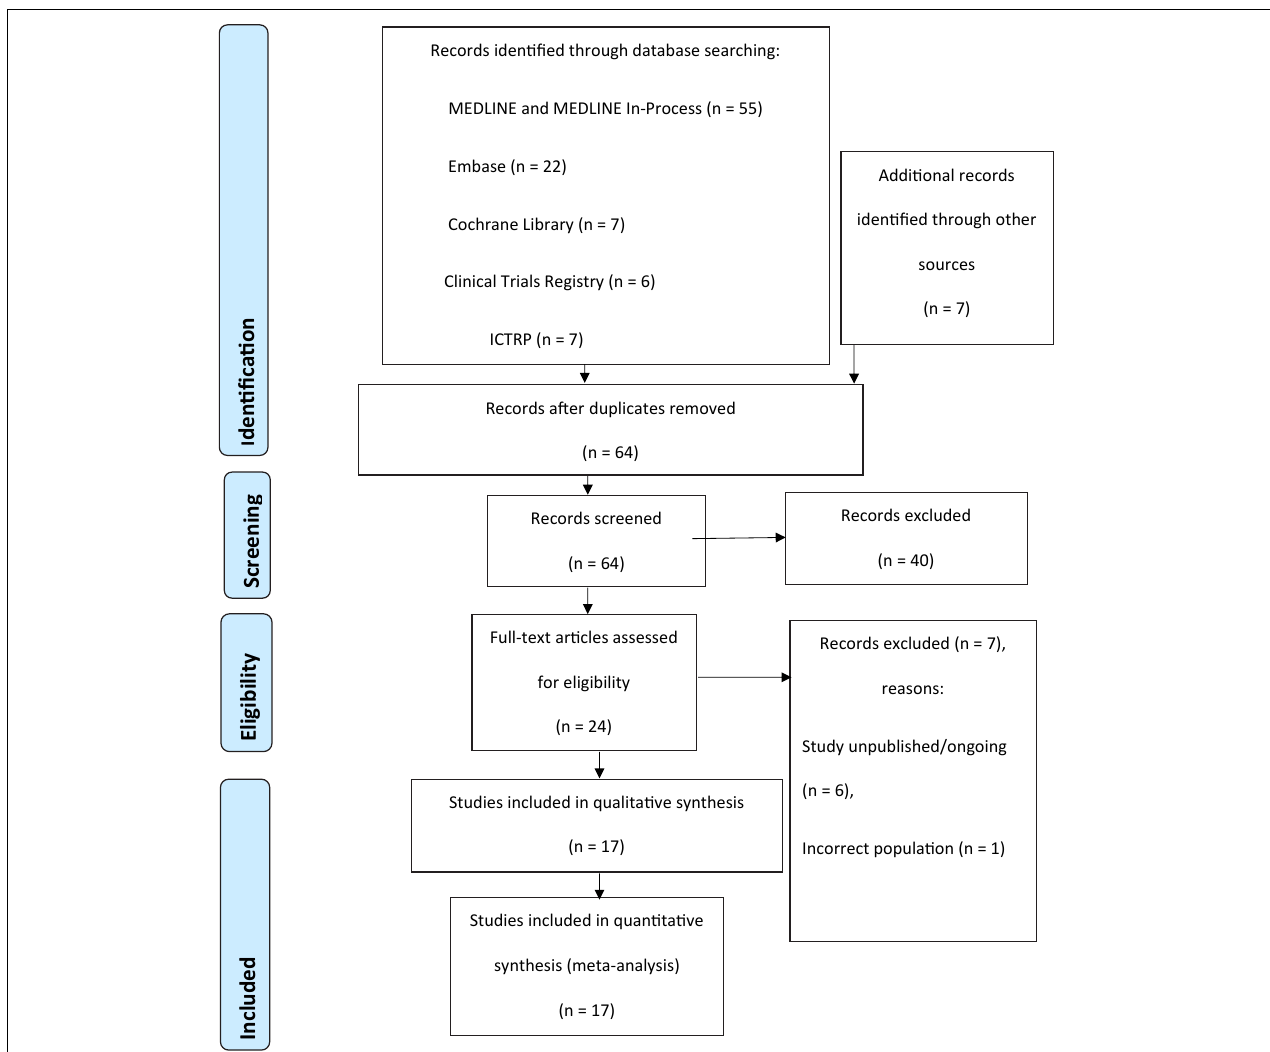
FIGURE 1 | PRISMA flow diagram for the systematic review. ICTRP, International Clinical Trials Registry Platform; PRISMA, Preferred Reporting Items for Systematic Reviews and Meta-Analyses.